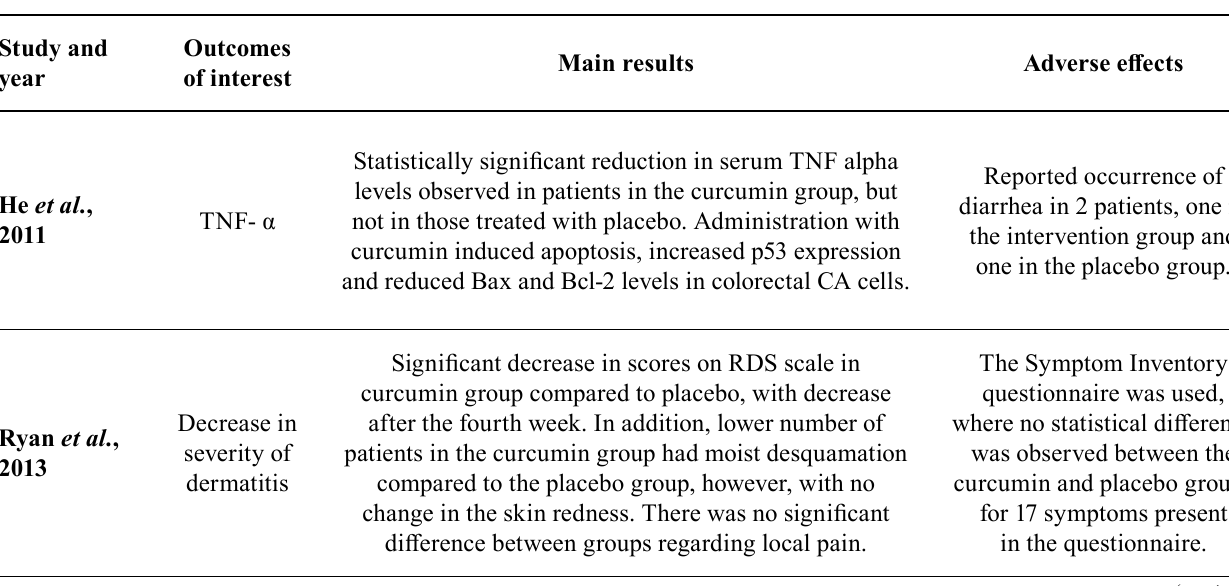
TABLE II – Summary of main results of clinical